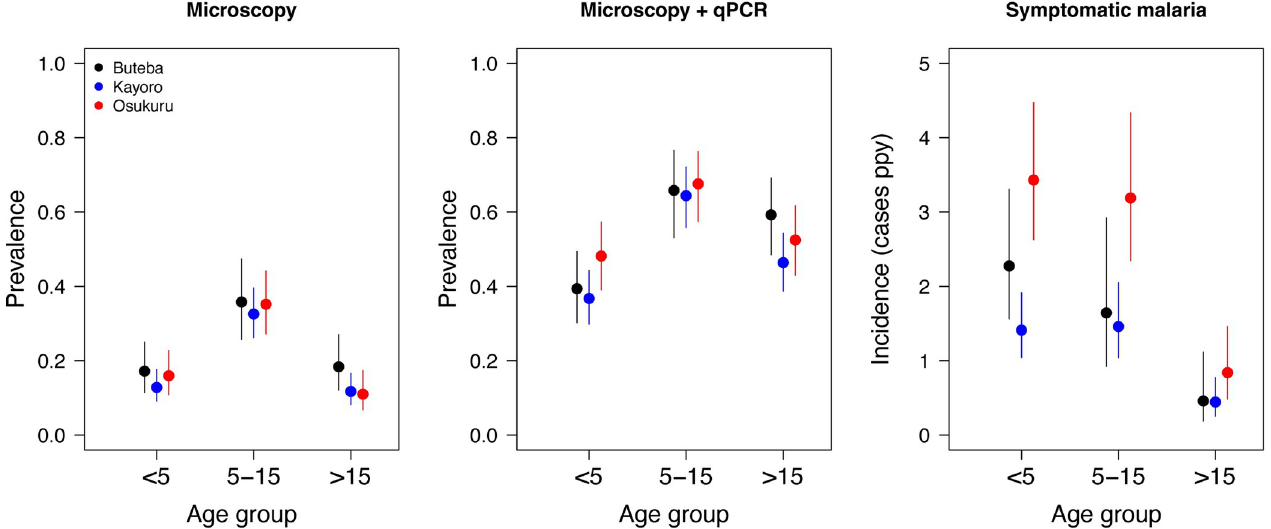
Fig 4. Prevalence of microscopic parasitemia and microscopic+ submicroscopic parasitemia as well as incidence of malaria across the three parishes stratified by age groups. All estimates (points) and 95% confidence intervals (lines) were calculated using generalized estimating equations with a binomial family and exchangeable correlation structure to account for repeated measures within individuals.